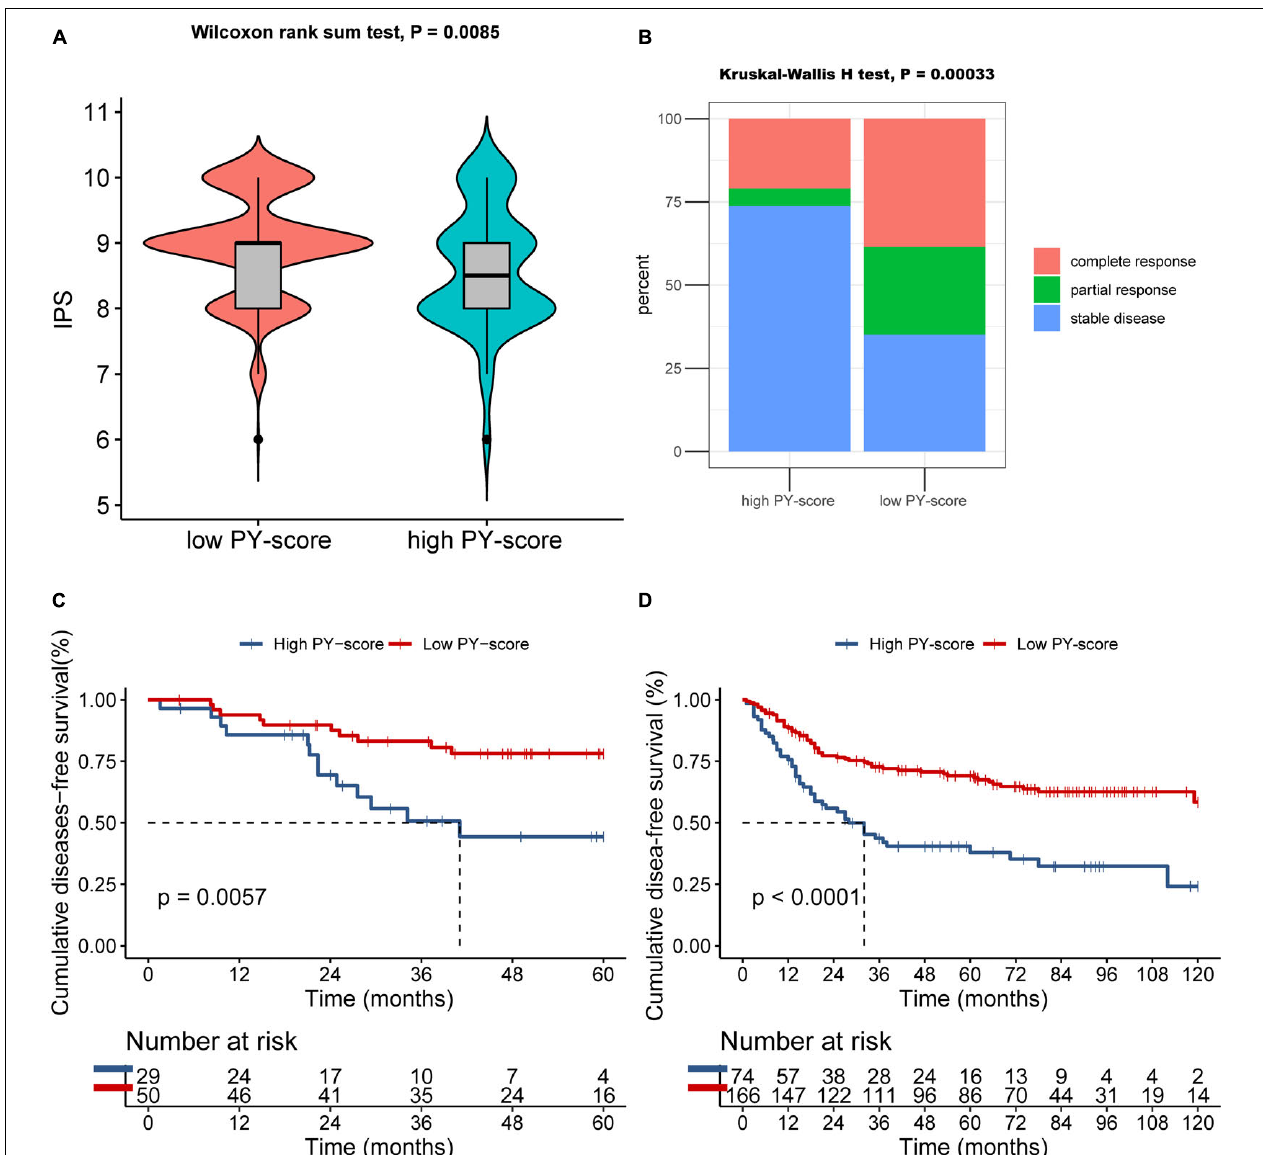
FIGURE 8 | Role of the pyroptosis score (PY-score) in immune checkpoint inhibitor (ICI) treatment, anti-epidermal growth factor receptor (EGFR) therapy, and chemotherapy. (A) Samples in the high PY-score group showed a significantly lower immunophenoscore (IPS) than did the samples in the low PY-score group in the meta-GEO cohort ( p = 0.0085). (B) Fraction of samples with clinical response to anti-EGFR therapy in the low and high PY-score groups of the GSE140973 cohort ( p < 0.001). (C,D) Survival analyses for patients who received chemotherapy from the low (558 cases) and high (168 cases) PY-score groups in the GSE14333 ( p < 0.001) (C) and from the low (558 cases) and high (168 cases) PY-score groups in the meta-GEO cohort ( p = 0.0057) (D) using Kaplan–Meier